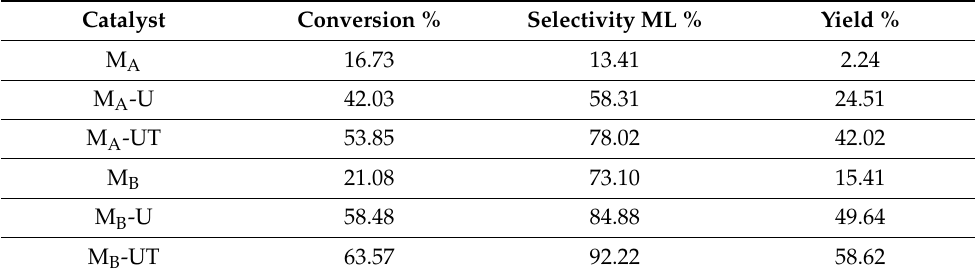
Table 5. Catalytic activity. T = 65 ◦ C, 0.05 g